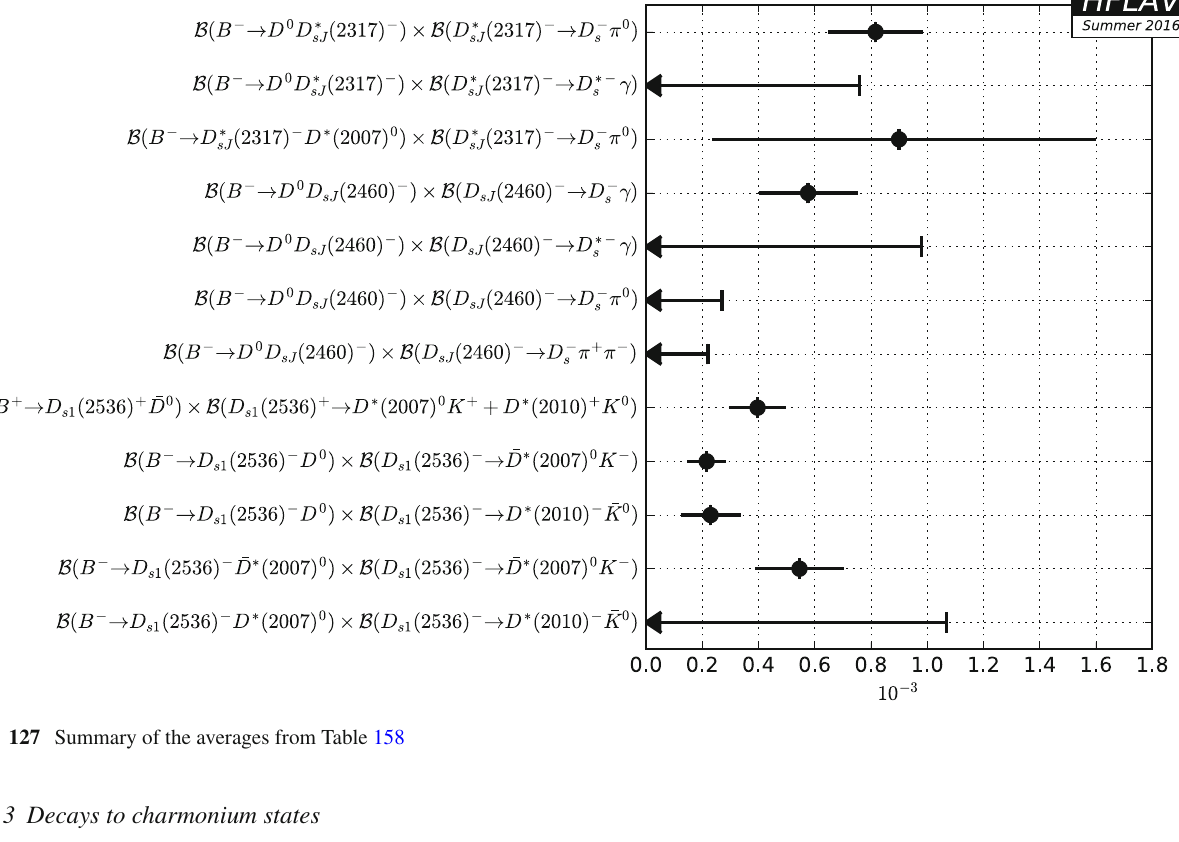
Averages of B − decays to charmonium states are shown in Tables 159, 160, 161, 162, 163, 164, 165, 166, 167, 168, 169 and Figs. 128, 129, 130, 131, 132, 133, 134, 135, 136, 137, 138. Table 159 Decays to J /ψ and one kaon I [ 10 − 3 ] Parameter